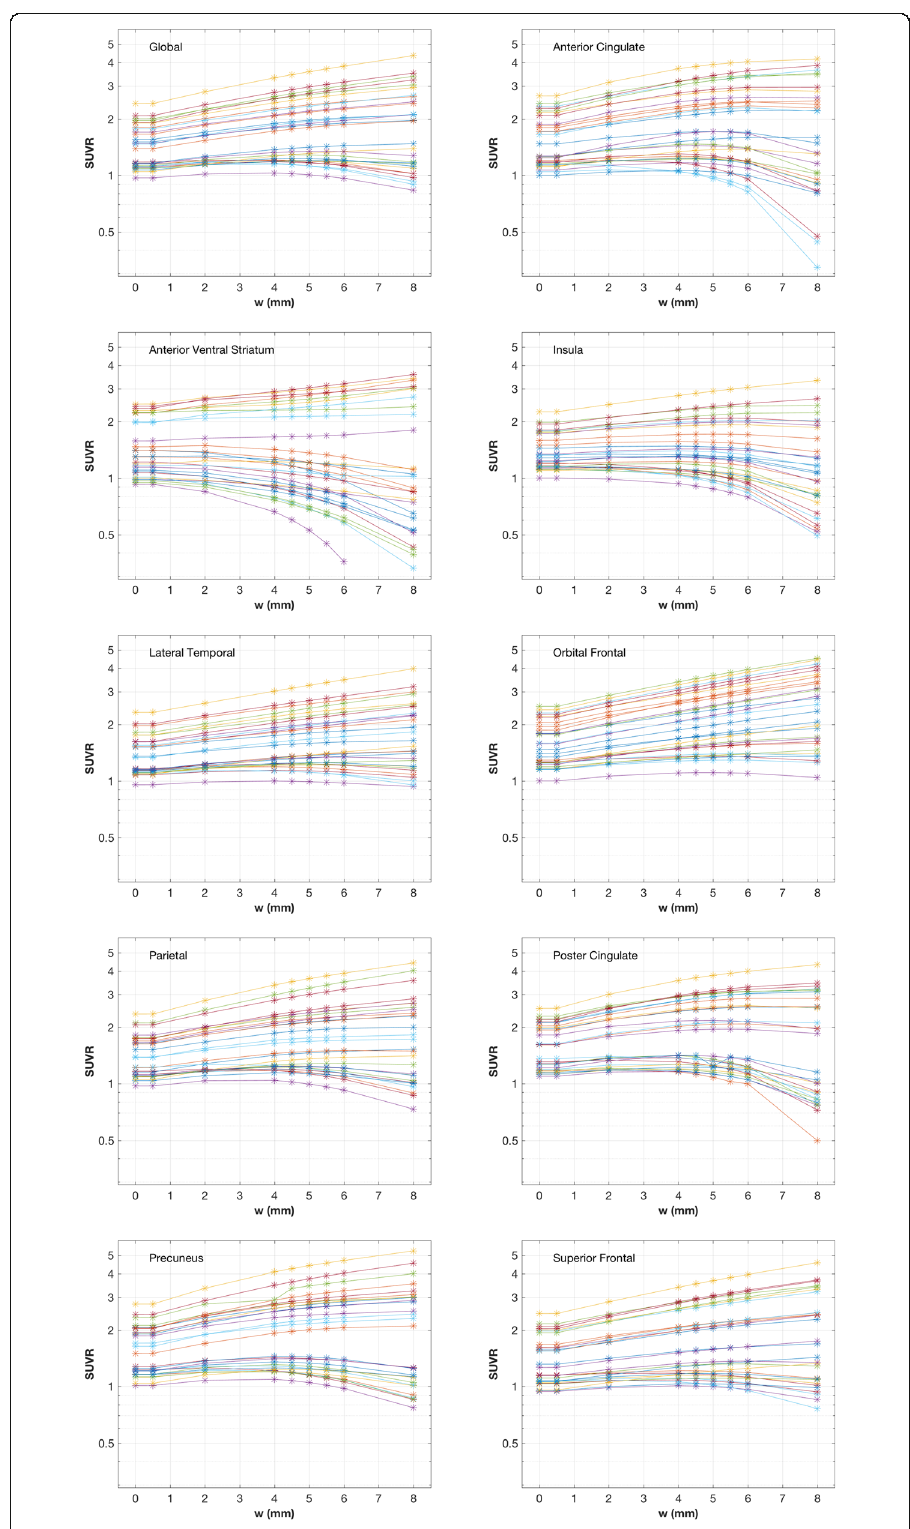
Fig. 1 (See legend on next